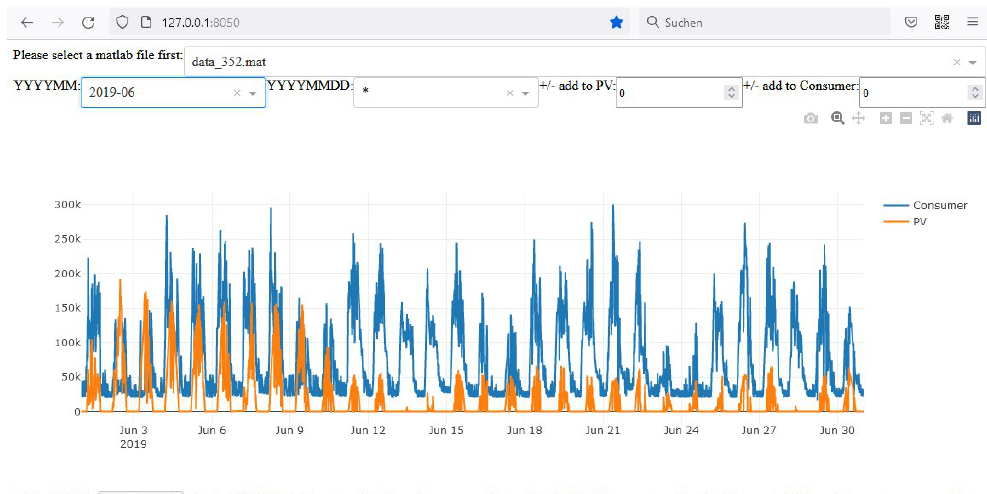
Figure A2. A sample month in the profile extraction tool.